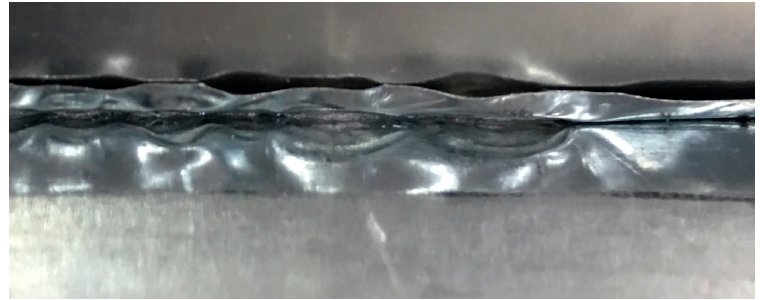
Figure 8. Macroscopic longitudinal section of weld.